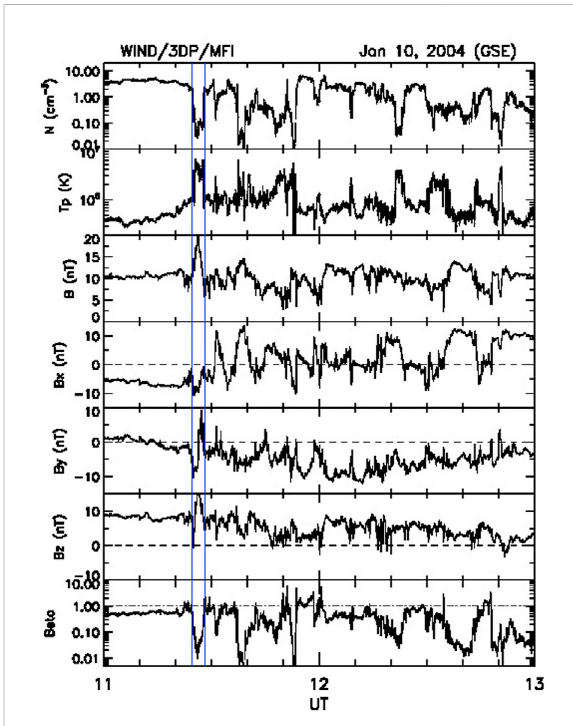
FIGURE 1 Proton and magnetic fi eld data from spacecraft Wind during 11 – 13 UT, 10 January 2004. From top to bottom: the proton density, temperature, total fi eld and its GSE components, and the proton beta.